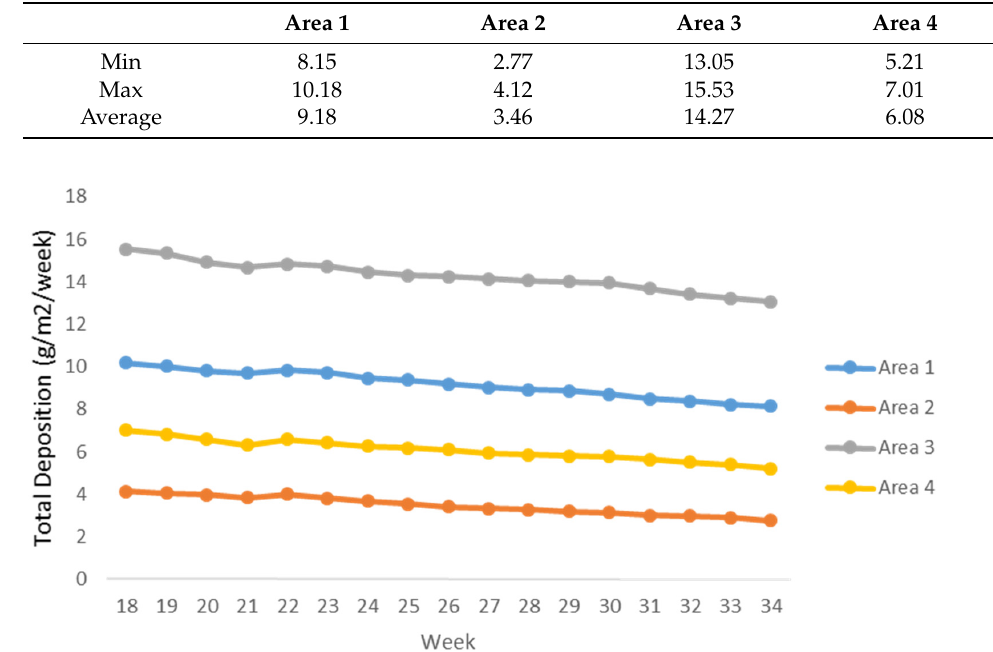
Figure 5. Total depositions in the four areas in the rainy